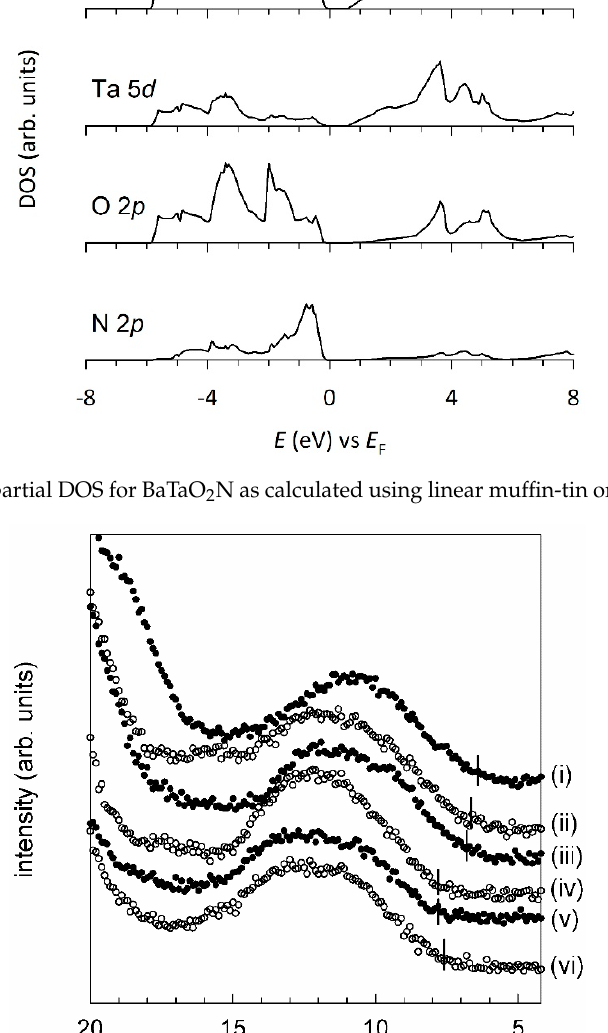
Figure 4. Valence level XPS spectra for ( i ) BaTaO 2 N, ( ii ) SrTaO 2 N, ( iii ) CaTaO 2 N, ( iv ) KTaO 3 , ( v ) NaTaO 3 , and ( vi ) TaO 2 F. Vertical bar on each data indicates the top edge of the valence band.